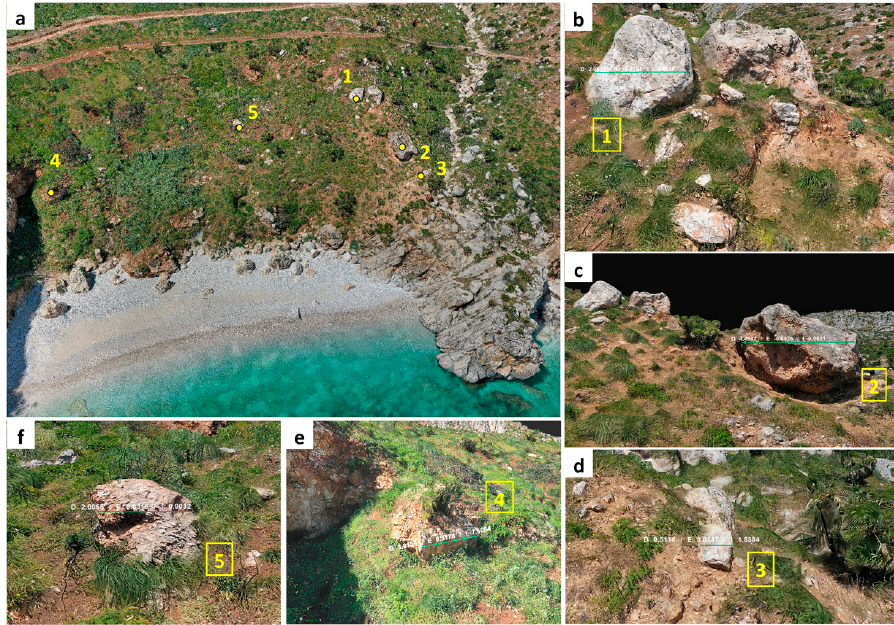
Figure 7. ( a ) The collapsed blocks resting on the cover. ( b – f ) Some examples of surveyed and measured boulders, as described in the